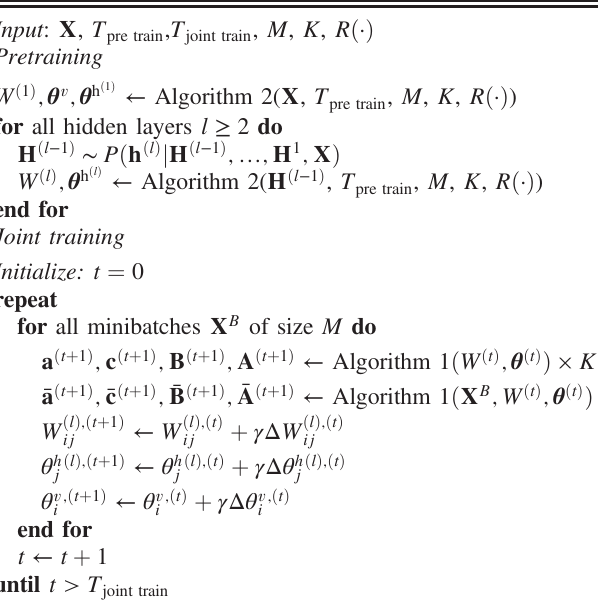
Algorithm 3. AdaTAP inference for binary-binary RBMs. Algorithm 4. GDBM training.